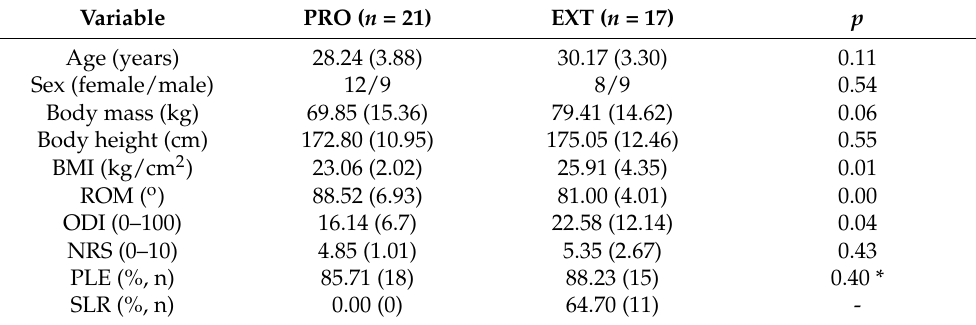
Table 1. Subjects’ demographic and clinical characteristics.